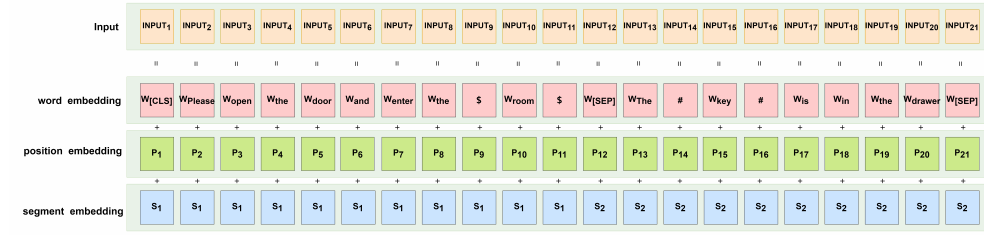
Figure 2. Embedded process.